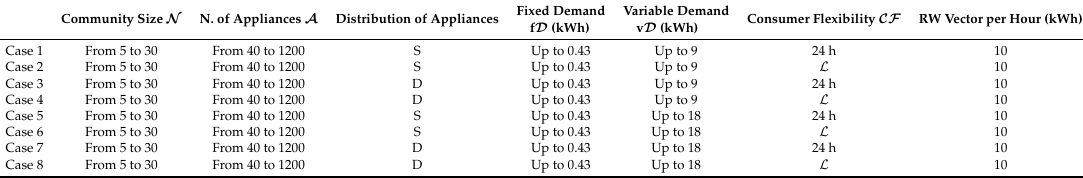
Table 4. Possible load-shape